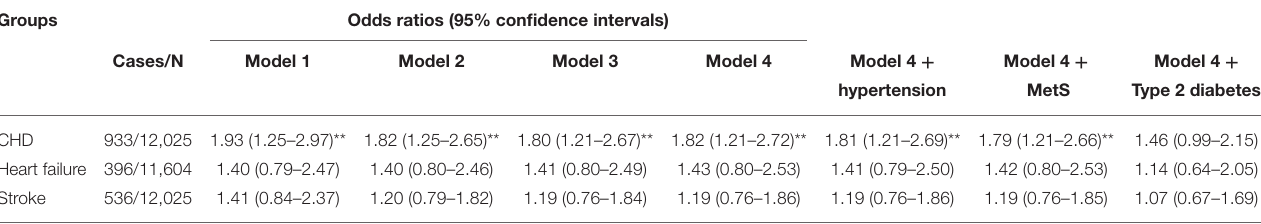
TABLE 3 | Odds ratios of coronary heart disease, heart failure and stroke for women with a history of gestational diabetes mellitus compared with those without a history of gestational diabetes mellitus.